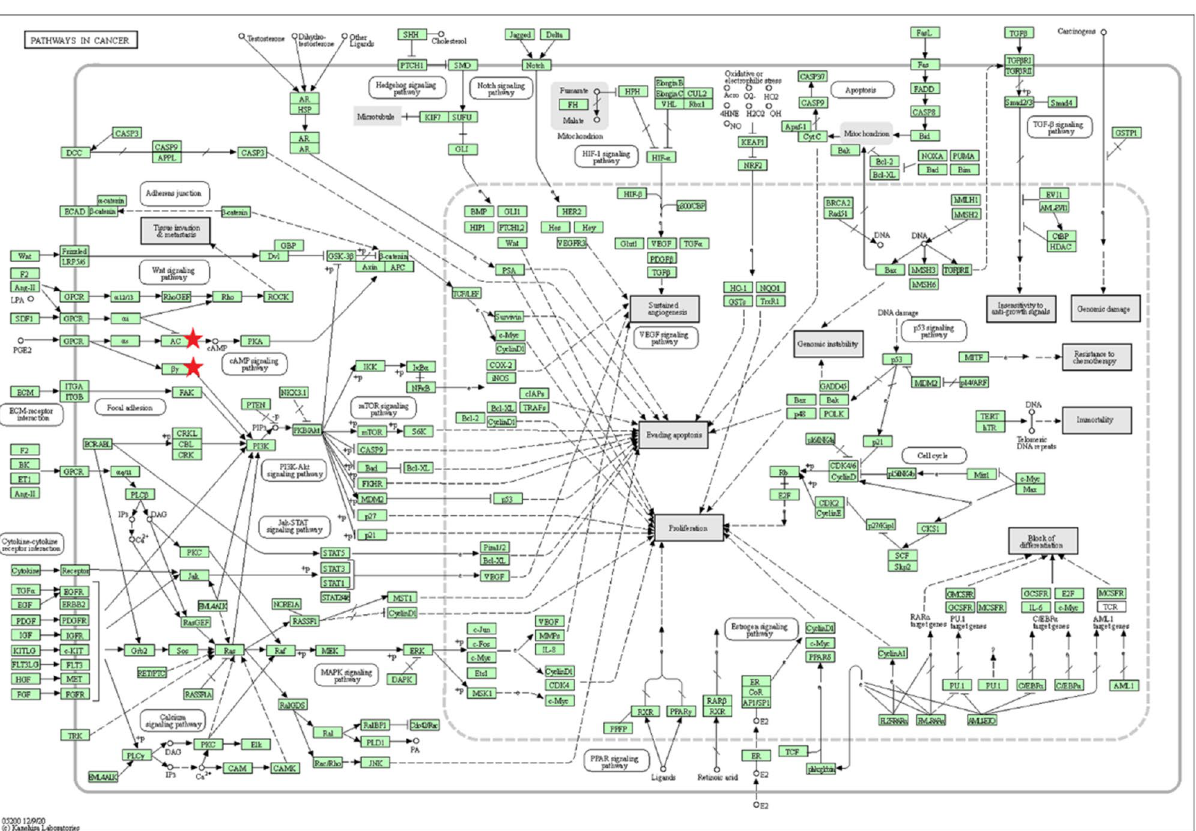
Figure 5. Reanalysis of 13 validated genes via KEGG pathway enrichment. two genes ( GNG7, ADCY1 ) were markedly enriched in the Pathways in Cancer (https:// www. kegg. jpkegg/ kegg1. html). AC means ADCY1 . βy means GNG7